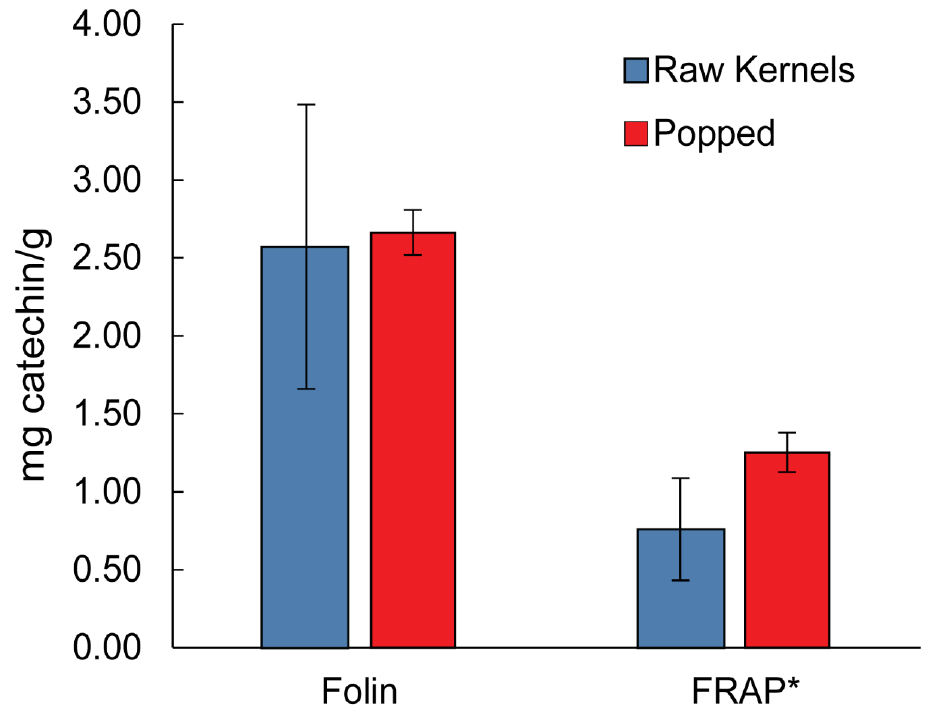
Figure 4. Average total phenolic content by Folin and antioxidant capacity by FRAP (mg catechin/g) of samples processed through in vitro digestion. * For antioxidant capacity, there is a significant increase in iron reducing power (n = 3, p<0.05).